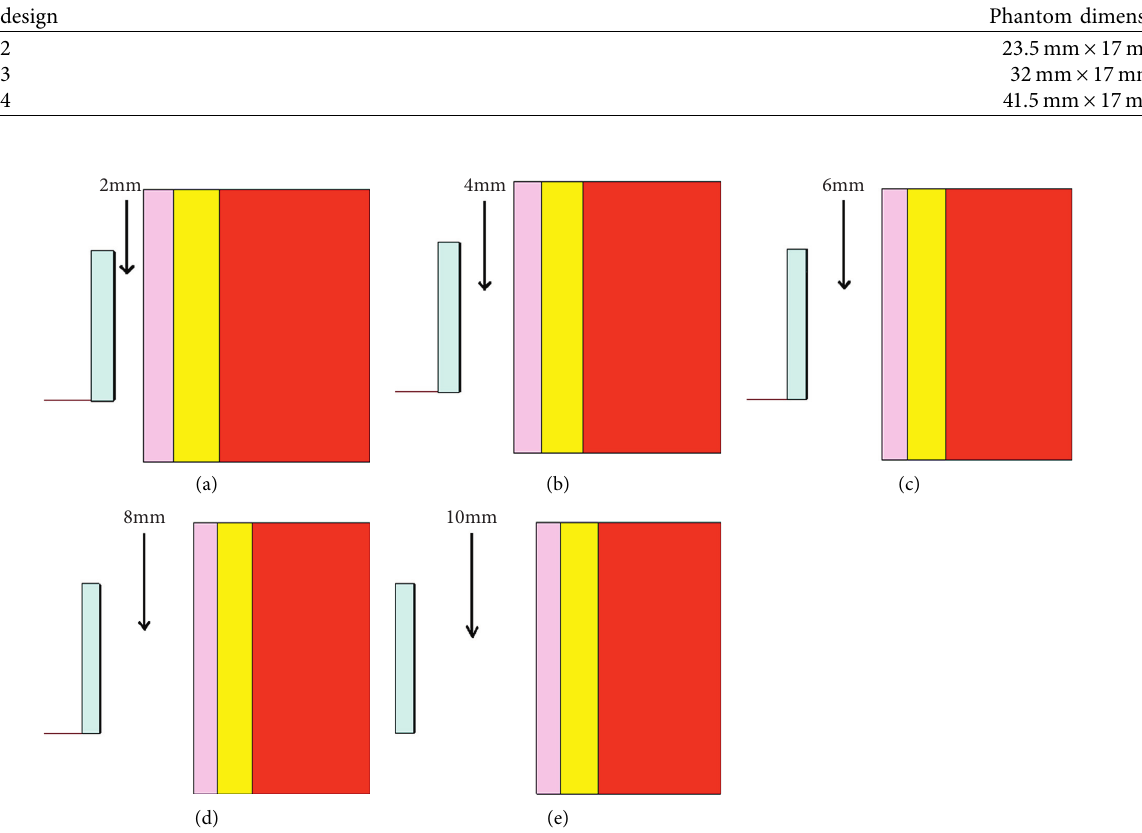
Figure 20: Arrays placed at 5 different distances away from phantom. (a) 2 mm. (b) 4mm. (c) 6mm. (d) 8mm. (e) 10mm.